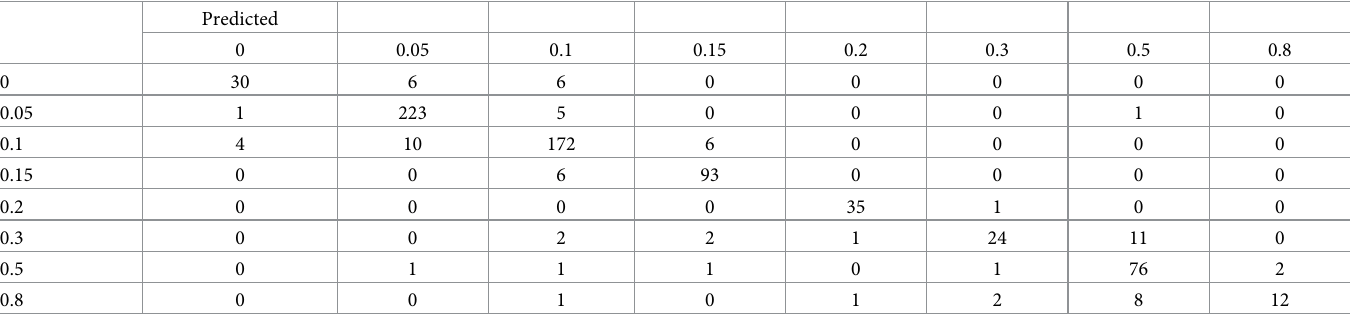
Table 7. Multinomial logistic regression on spectral data obtained from C3H/HeJ mice only. Data was classified based on degree of pneumonitis (regional pathology grades).